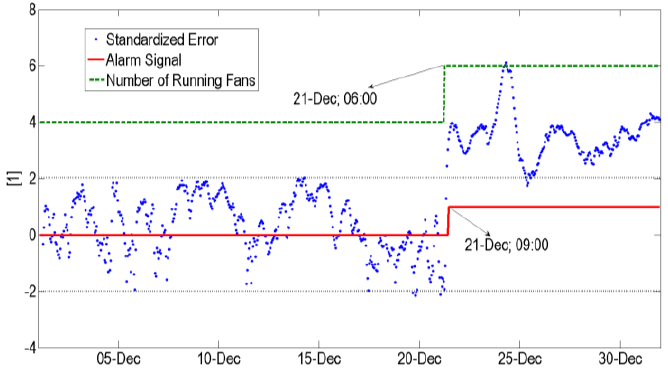
Figure 23. Standardized error between measured and calculated oil temperature for faulty operation of fans.